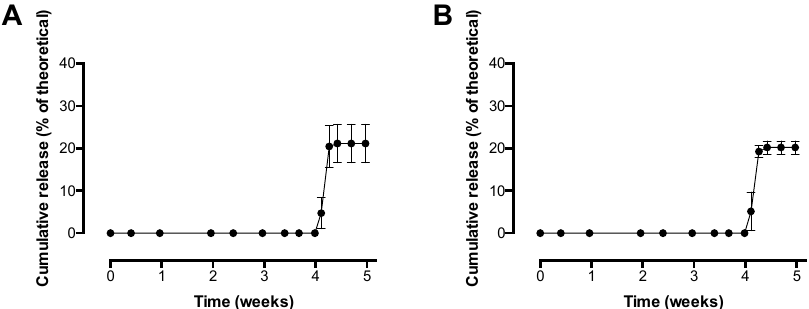
Figure 7. In vitro release of pre-F from pre-F-containing core-shell implants. ( A ) shows the release of pre-F measured with CR9501-biotin as detection antibody, while ( B ) shows the release of pre-F measured with CR9506-biotin as detection antibody. For each time point, n = 3, mean and standard deviation are given.